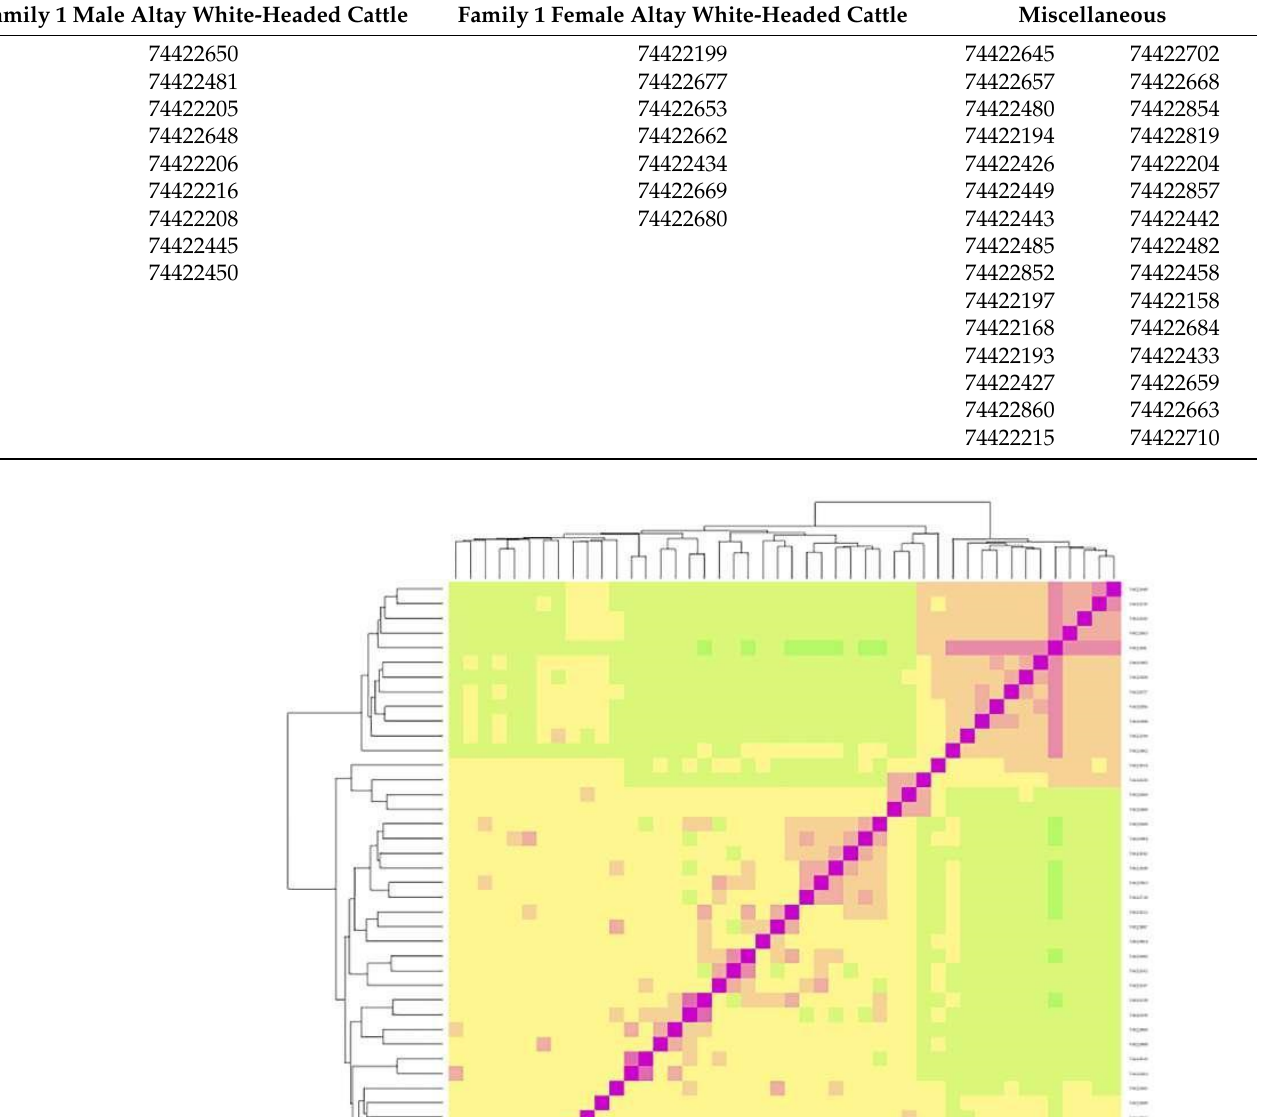
Table 3. Results of population and family construction.